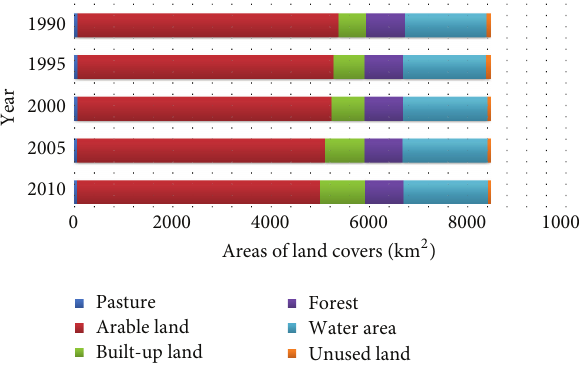
Figure 3: LULC in the Wuhan city from 1990 to